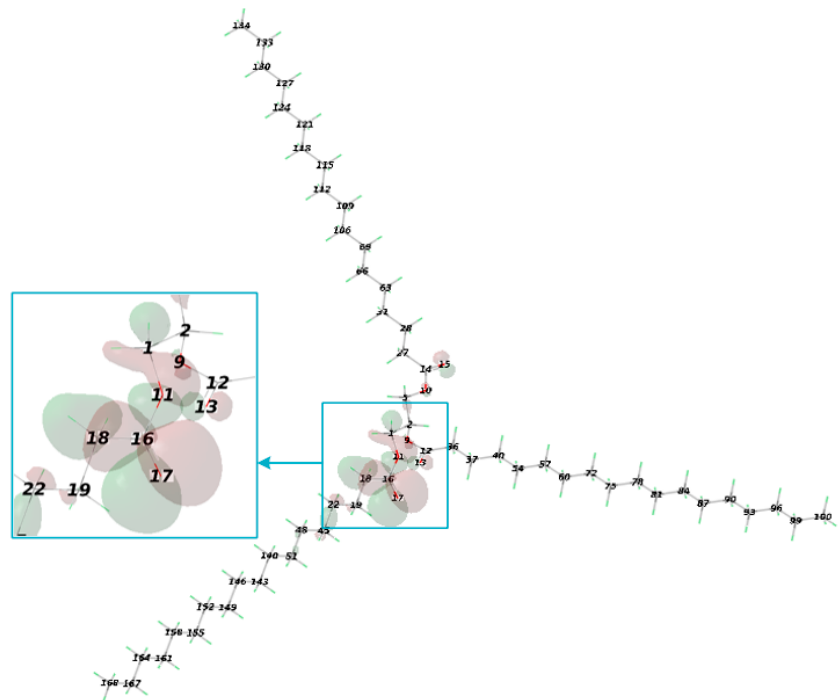
Figure 5. Isosurface of HOMO of tristearin molecule.